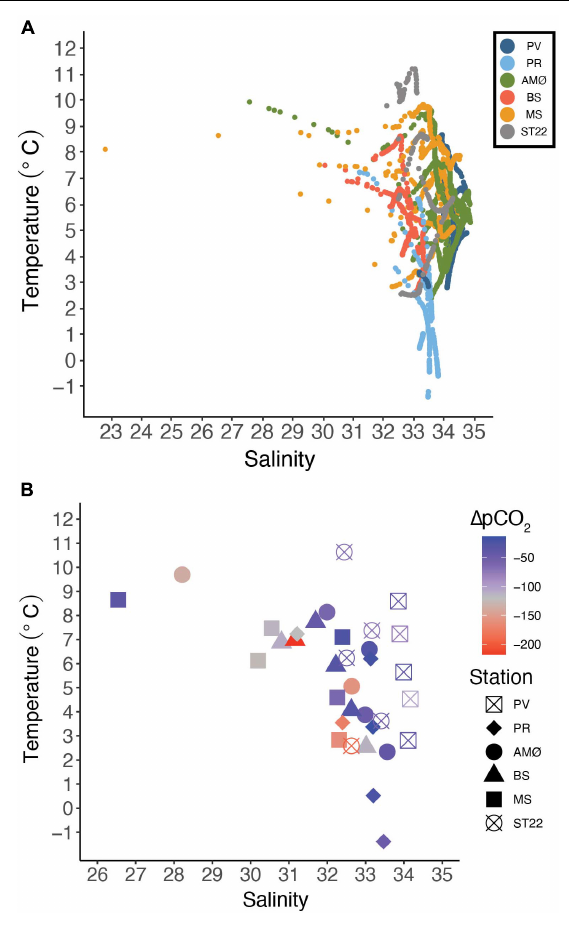
FIGURE 2 | Temperature-salinity (A) plot from June 2018–2019 showing all the CTD casts from stations marked with different colors. (B) Temperature-salinity relationship in surface water (5 m) and (cid:49) pCO 2 ( µ atm) visualized by colors and stations with different symbols (note the different scales on salinity).